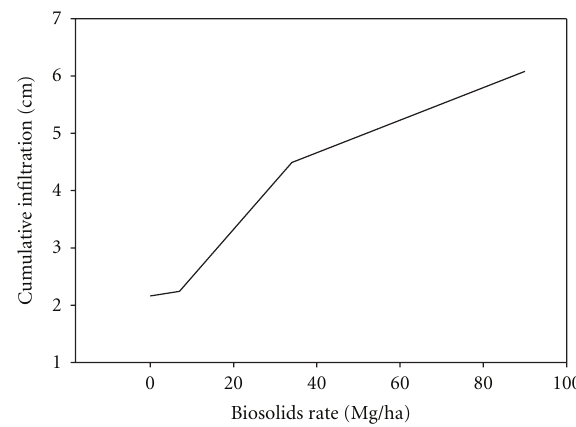
Figure 9: Cumulative infiltration for the Chilicotal soil as a function of biosolids rate on the Sierra Blanca